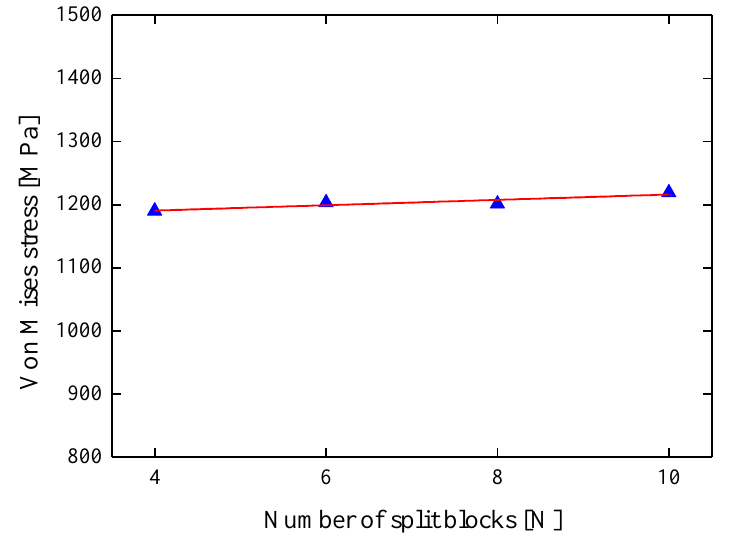
Figure 10. Magnitudes of von Mises stress on the first layer supporting rings with different numbers of split blocks.